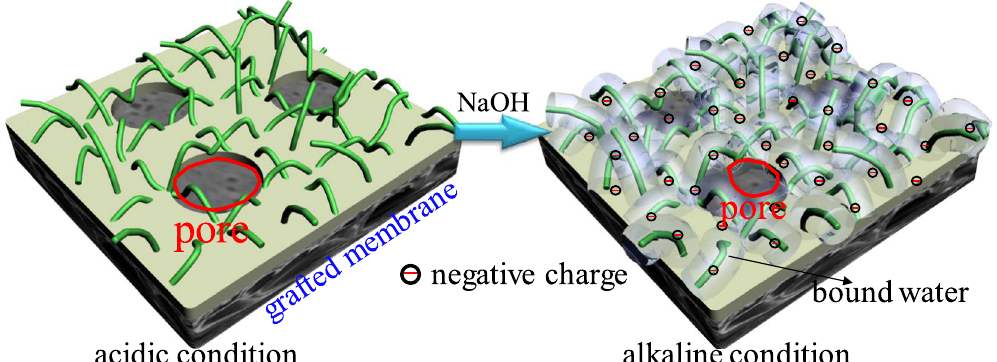
Figure 9. Schematic illustration of the configurational change of poly (HEA) chains grafted on membrane surface from acidic condition to alkaline